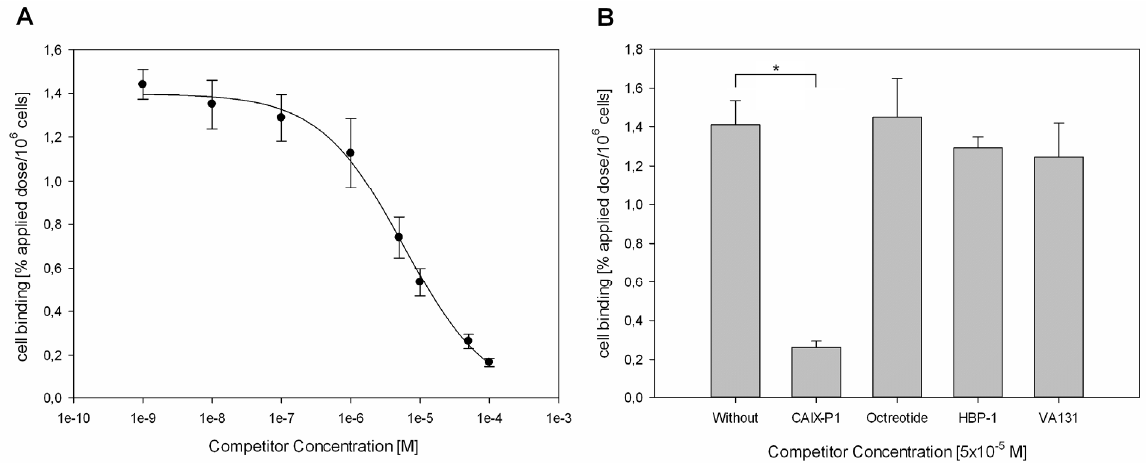
Figure 11. ( A ) Binding inhibition of 125 I-CaIX-P1 by the unlabeled CaIX-P1 peptide at various concentrations on HCT116 cells. ( B ) Specific binding of 125 I-CaIX-P1 on HCT116 cells. Non-specific binding was determined through co-incubation with 5 × 10 − 5 M unlabeled CaIX-P1. Octreotide, HBP-1 and VA131 were used as negative control competitors at the same